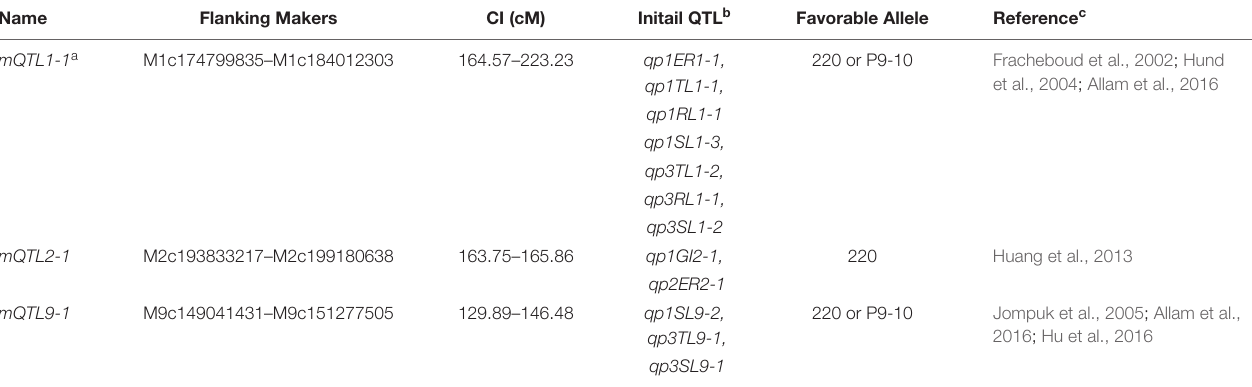
FIGURE 3 | QTL for low temperature germination related traits represented in the consensus linkage map of the three populations of 220 × PH4CV, 220 × Y1518, and P9-10 × PH4CV. The circle, triangle, square, star and pentagon represented traits of ER, GI, TL, RL, and SL. ER and GI were collected from sand bed experiment, and TL, RL, and SL were collected from paper rolls experiment. Color red, green and blue indicated QTL detected from population 220 × PH4CV, 220 × Y1518, and P9-10 × PH4CV, respectively. TABLE 3 | Meta-QTL (mQTL) detected from the consensus linkage